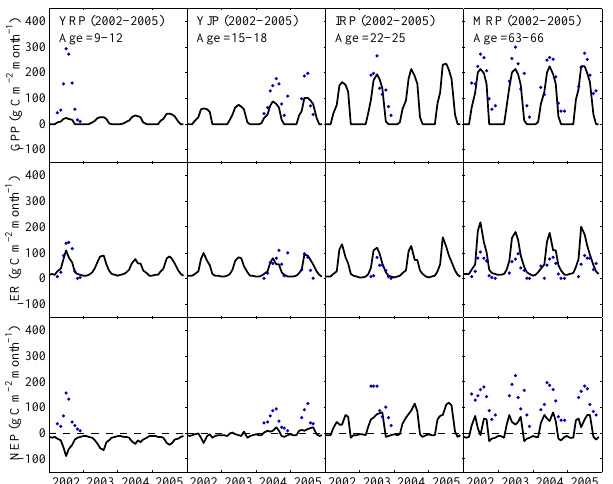
Figure 1. Simulated (lines) and observed (symbols) monthly carbon fluxes: GPP, ER, and NEP for the deciduous broadleaf chronose- quence sites from 1999–2007.